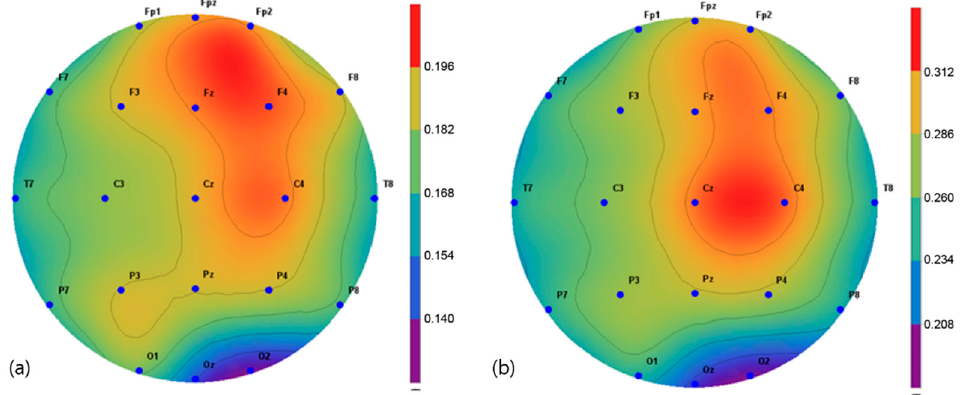
Figure 7. Mapping of the beta power value ( a ) before and ( b ) after training in the normal bilateral arm training group.